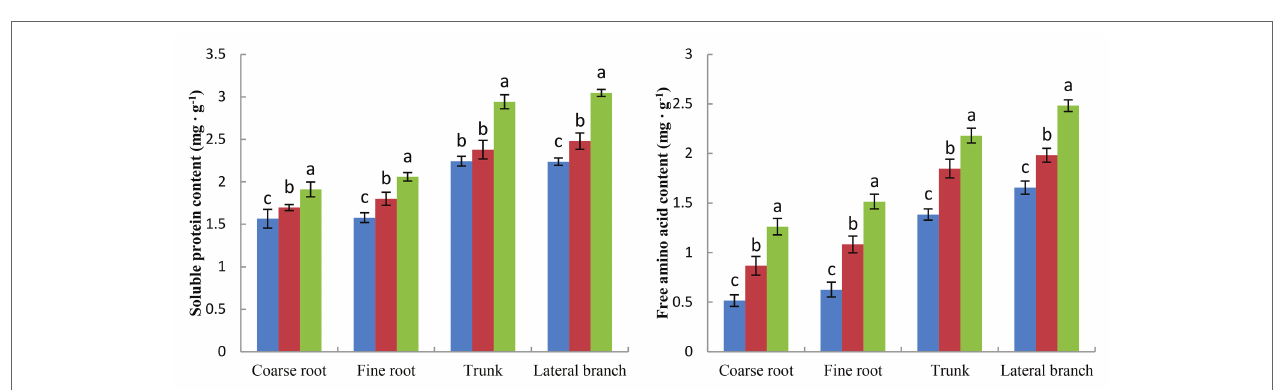
FIGURE 7 | Effects of BCRF on soluble sugar content and starch content in different organs. The vertical bars indicate the standard deviation of three replications. Different letters indicate statistically significant differences ( p < 0.05).